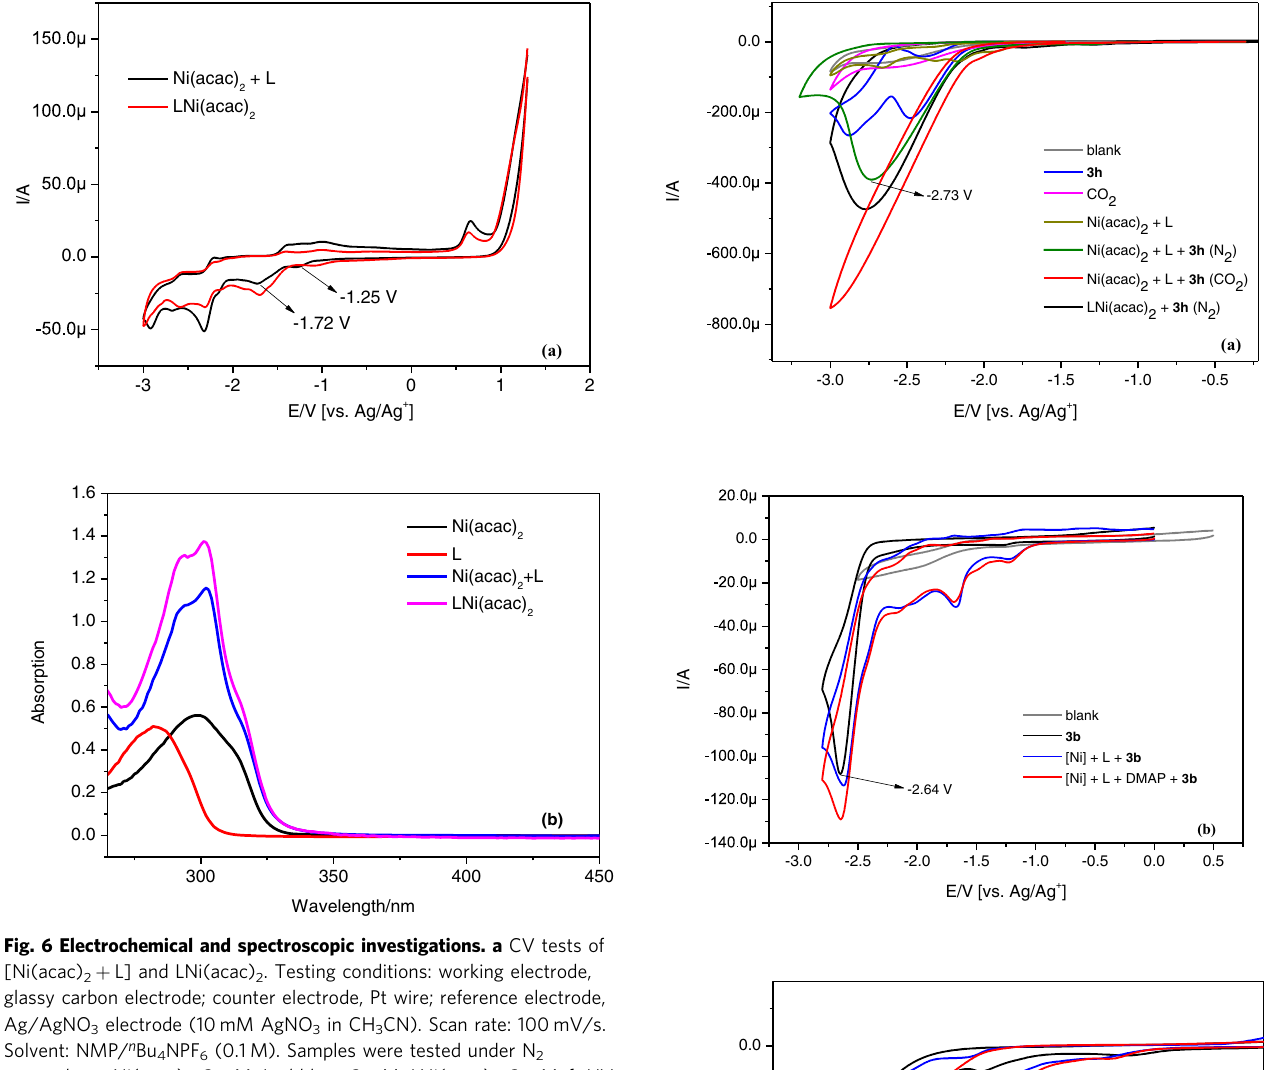
of such catalytic system in reductive couplings is underway in our laboratory. Methods Synthesis of 1a – 1f, 1i – 1l, 3a – 3c, 3e, 3i – 3l, 3p, 3s, and 3aa . In a 50 mL three- neck fl ask equipped with a carbon felt cathode and a Zn plate, aryl halides (0.3 mmol), NiBr 2 (cid:129) DME (0.03 mmol, 10 mol%), 4,4 ′ -di-tert-butyl-2,2 ′ -bipyr- idine (0.03 mmol, 10 mol%), DMAP (0.06 mmol, 20 mol%), KO t Bu (0.15 mmol, 0.5 equiv), anhydrous MgBr 2 (0.45 mmol, 1.5 equiv), NaI (1.2 mmol) were loaded in the glove box. Then the mixture was taken out of the box, degassed under vacuum, and back- fi lled with CO 2 gas for fi ve times (each time lasted for 1 min). After that, anhydrous NMP (6 mL) was injected into the fl ask via a syringe and dissolved the mixture under the strong stirring until the mixture becoming transparent. Then two electrodes were submerged into the solution and conducted under 60 °C. Constant current (10 mA) was passed until the starting material was consumed. After electrolysis, the mixture was acidized by 2 N HCl solution (20 mL) and extracted by EtOAc for four times (30 mL × 4). The combined organic layers were washed with water (20 mL × 2) and brine (20 mL) and concentrated in vacuo. Then the residue was puri fi ed by silica gel column chromatography by using the petroleum ether/EtOAc to give out the carboxylic acid.